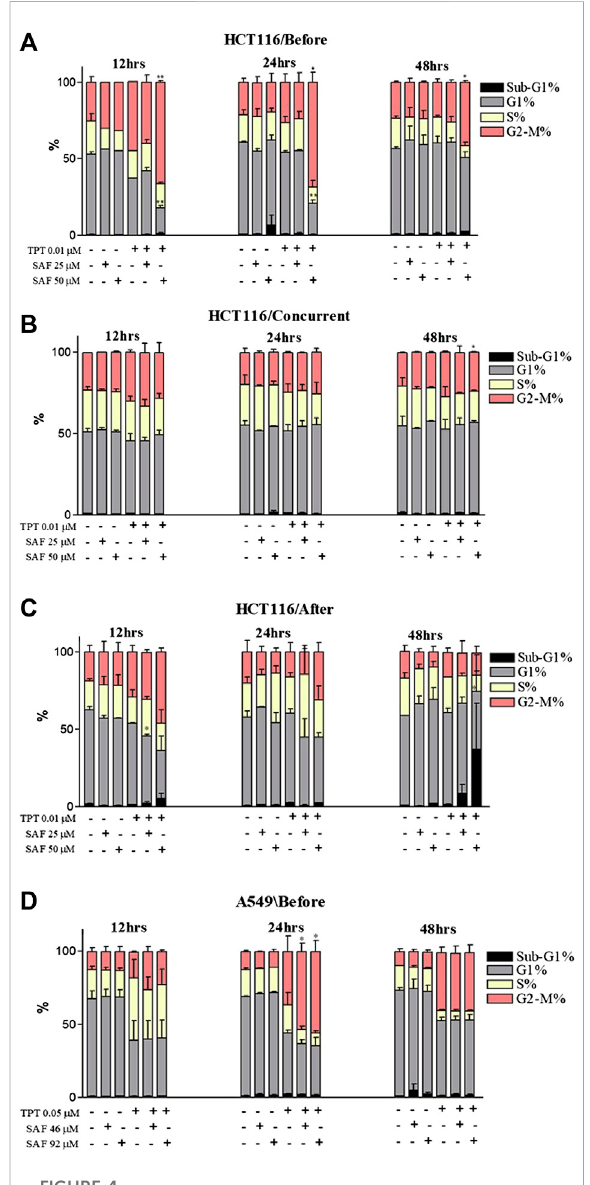
FIGURE 4 Cell cycle distribution analysis of HCT116 and A549 cells treated with SAF IC25/IC50 and TPT IC50 µM for different time intervals and sequences. (A – C) HCT116 cells treated with SAF IC25/IC50 24 h before TPT 0.01 µM (A) , concurrently with TPT 0.01 µM (B) , and 24 h after TPT 0.01 µM (C) , the